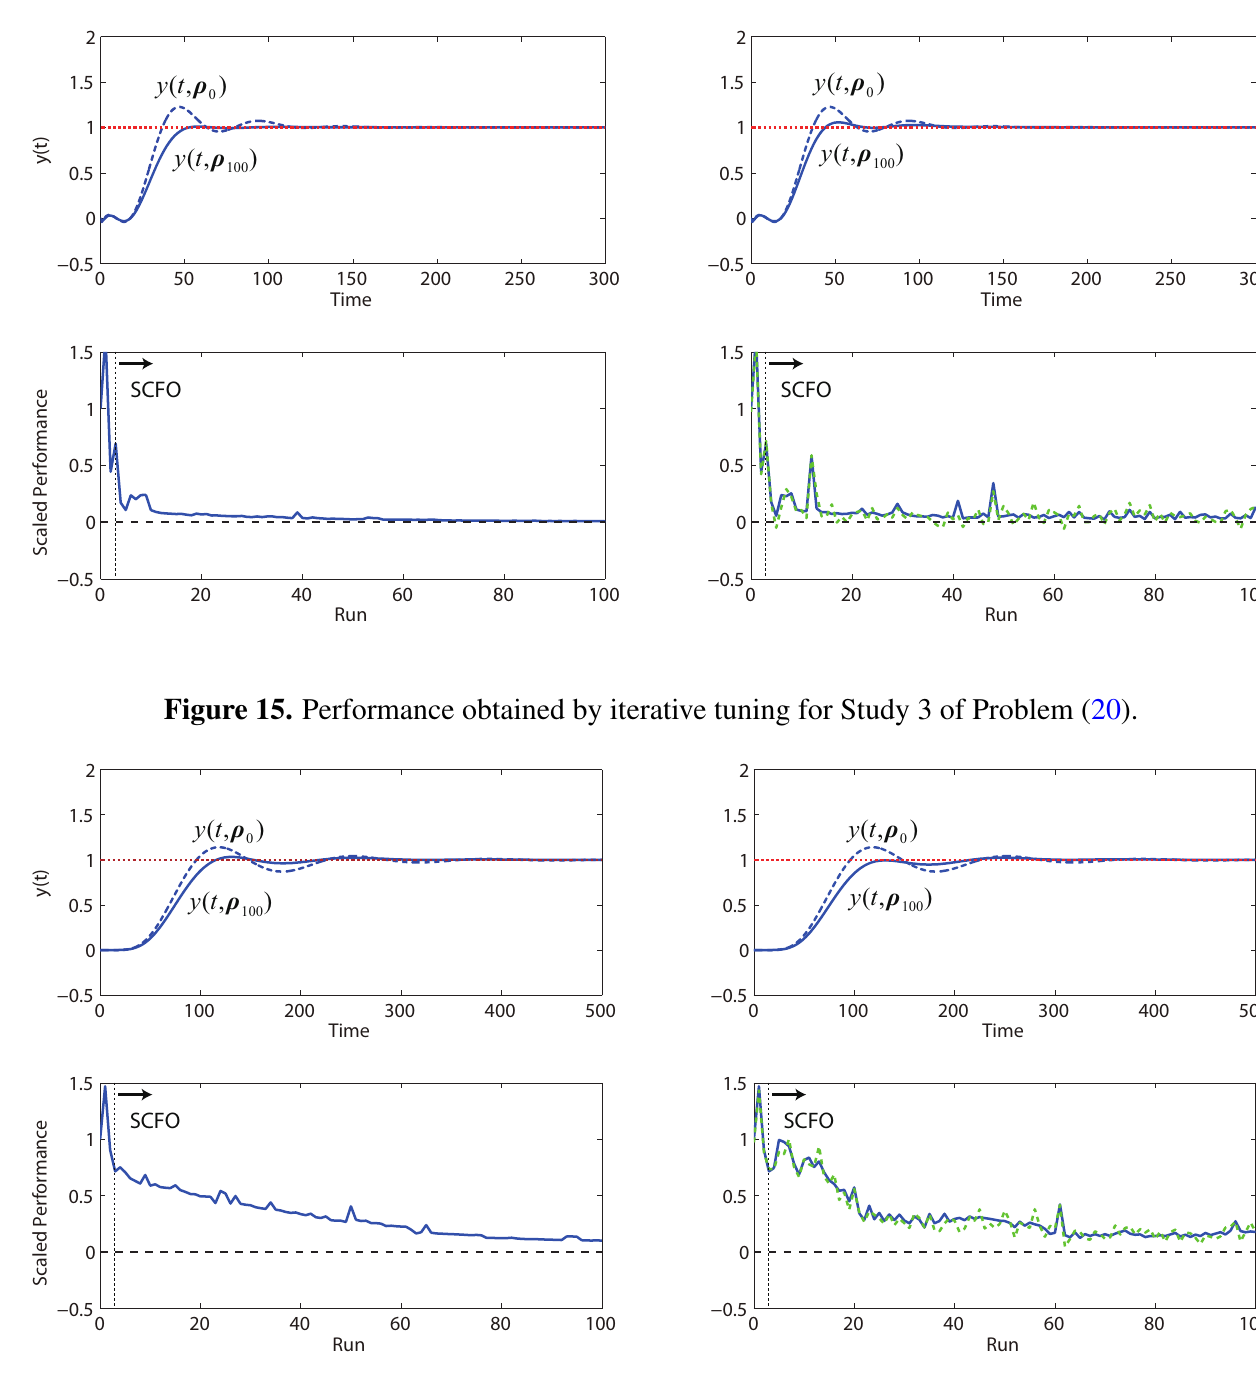
Figure 14. Performance obtained by iterative tuning for Study 2 of Problem (20).